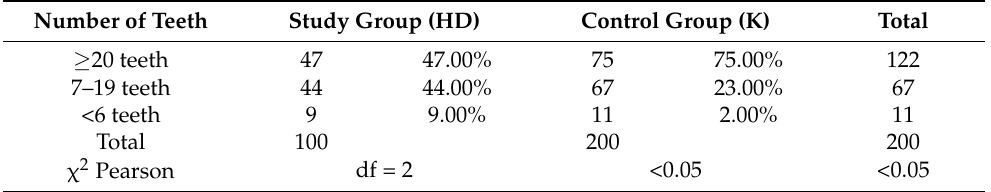
Table 8. Comparison of the number of teeth retained in the oral cavity in both study groups (HD.